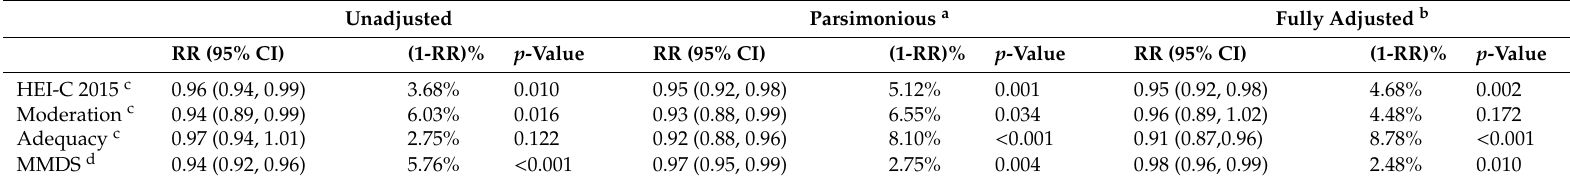
Table 3. Associations of increases in HEI-C 2015 and MMDS scores with number of physician visits for depression ( n = 25,016). Unadjusted Parsimonious a